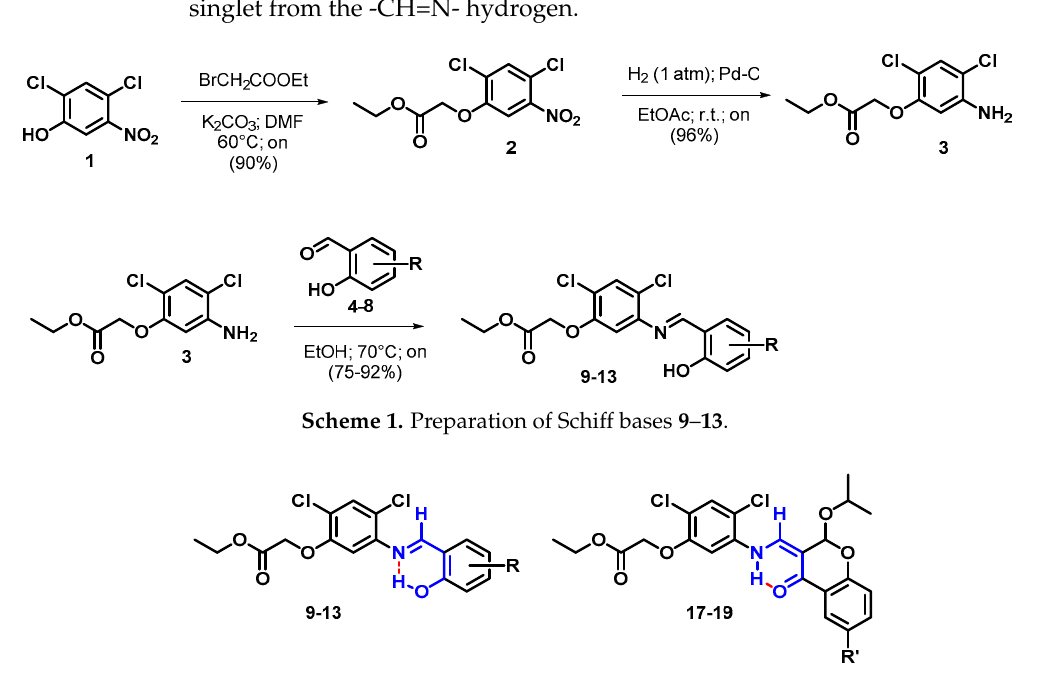
Figure 1. Intramolecular hydrogen bonds in Schiff bases 9 – 13 and chromanones 17 – 19 .